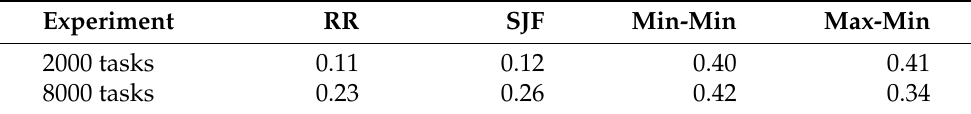
Table 9. Throughput (tasks per second).